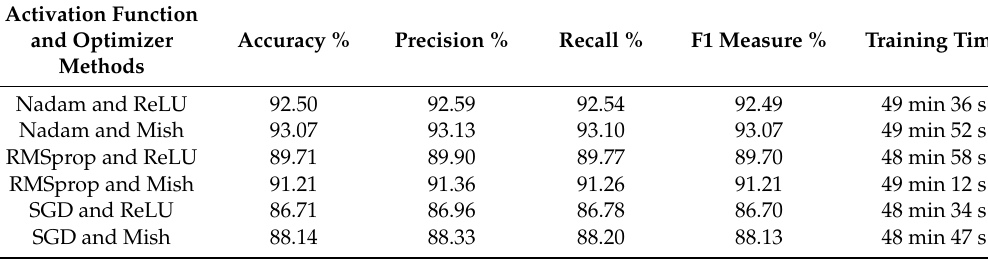
Table 8. The e ff ectiveness of ResNet-50 with ReLU and Mish combined with other